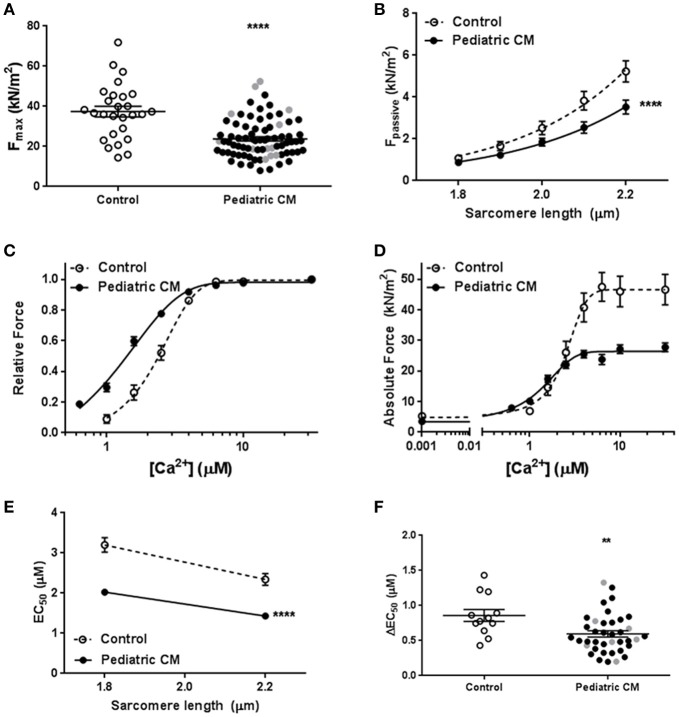
Baseline characteristics. (A) Maximal force was significantly lower in pediatric CM (23.8 ± 1.1, N = 11, n = 78) compared to controls (37.4 ± 2.6, N = 6, n = 27, p < 0.0001). (B) Fpass was significantly lower in pediatric CM (N = 11, n = 40) compared to controls (N = 10, n = 29, p < 0.0001) over a range of sarcomere lengths. (C) A leftward shift of the relative force vs. [Ca2+] indicates higher myofilament Ca2+-sensitivity in pediatric CM (N = 11, n = 38) compared to controls (N = 5, n = 12, p < 0.0001). (D) The absolute force development over a range of [Ca2+] showed pediatric CM have impaired maximal force development at saturating [Ca2+], increased force development at lower [Ca2+] and a decreased Fpass.
(E) Ca2+-sensitivity was significantly higher at sarcomere lengths of 1.8 and 2.2 μm in pediatric CM (N = 11, n = 38) compared to controls (N = 5, n = 12, p < 0.0001). (F) Length-dependent activation, measured as ΔEC50 was significantly lower in pediatric CM (0.60 ± 0.05, N = 11, n = 38) compared to controls (0.86 ± 0.09, N = 5, n = 12, p = 0.007). N, number of samples; n, number of cardiomyocytes measured. Measurements obtained from samples derived from patients with non-compaction cardiomyopathy are indicated in gray (A,F). **p < 0.01, ****p < 0.0001 vs. controls.